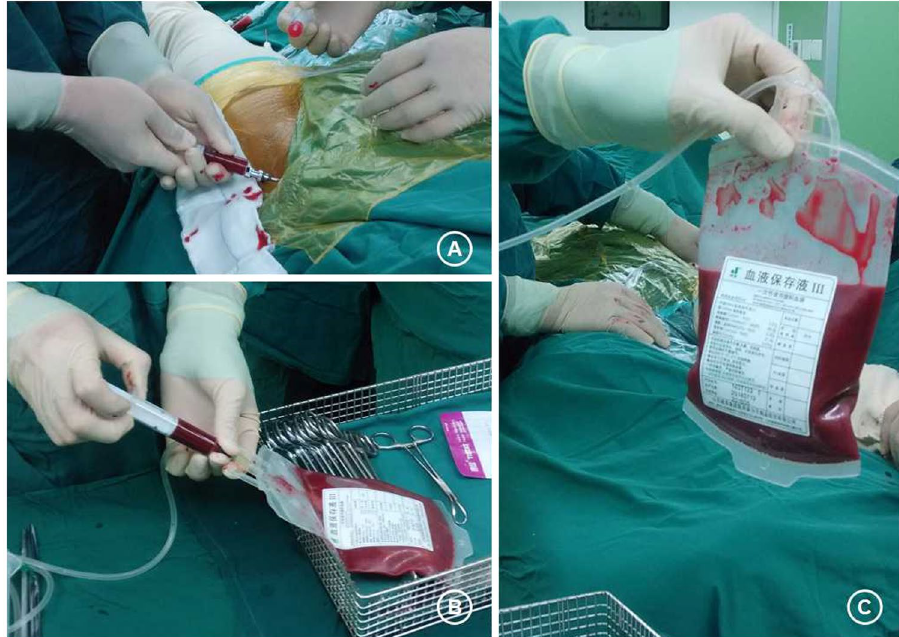
Figure 5. Bone marrow aspirates were harvested in sterile conditions from the anterior iliac crest ( A ), with the patient in the supine position under general or spinal anesthesia. A total of 100–200 ml bone marrow was aspirated per sample ( B,C